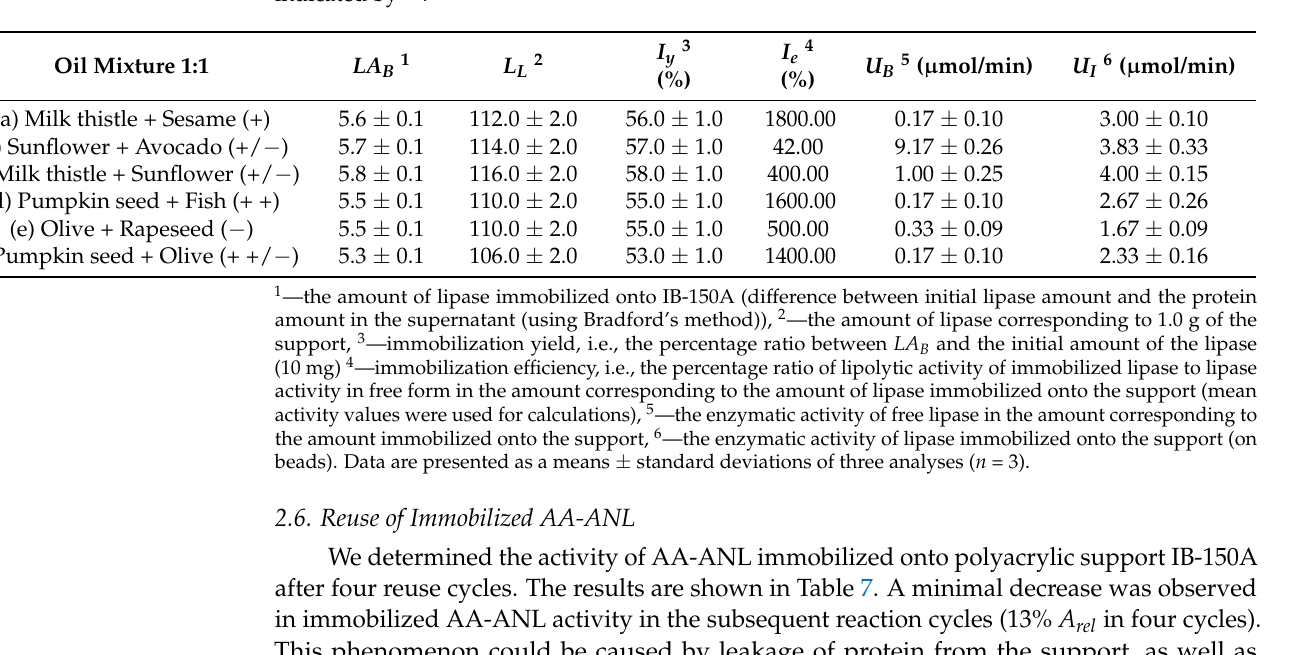
Table 6. Lipolytic activity of free and immobilized AA-ANL in substrate mixtures. The oils in which (Section 2.1) AA-ANL-IB-150A showed the highest lipolytic activity are indicated by + +, the oils with medium lipolytic activity are indicated by +, and the oils with the low AA-ANL-IB-150A activity are indicated by −